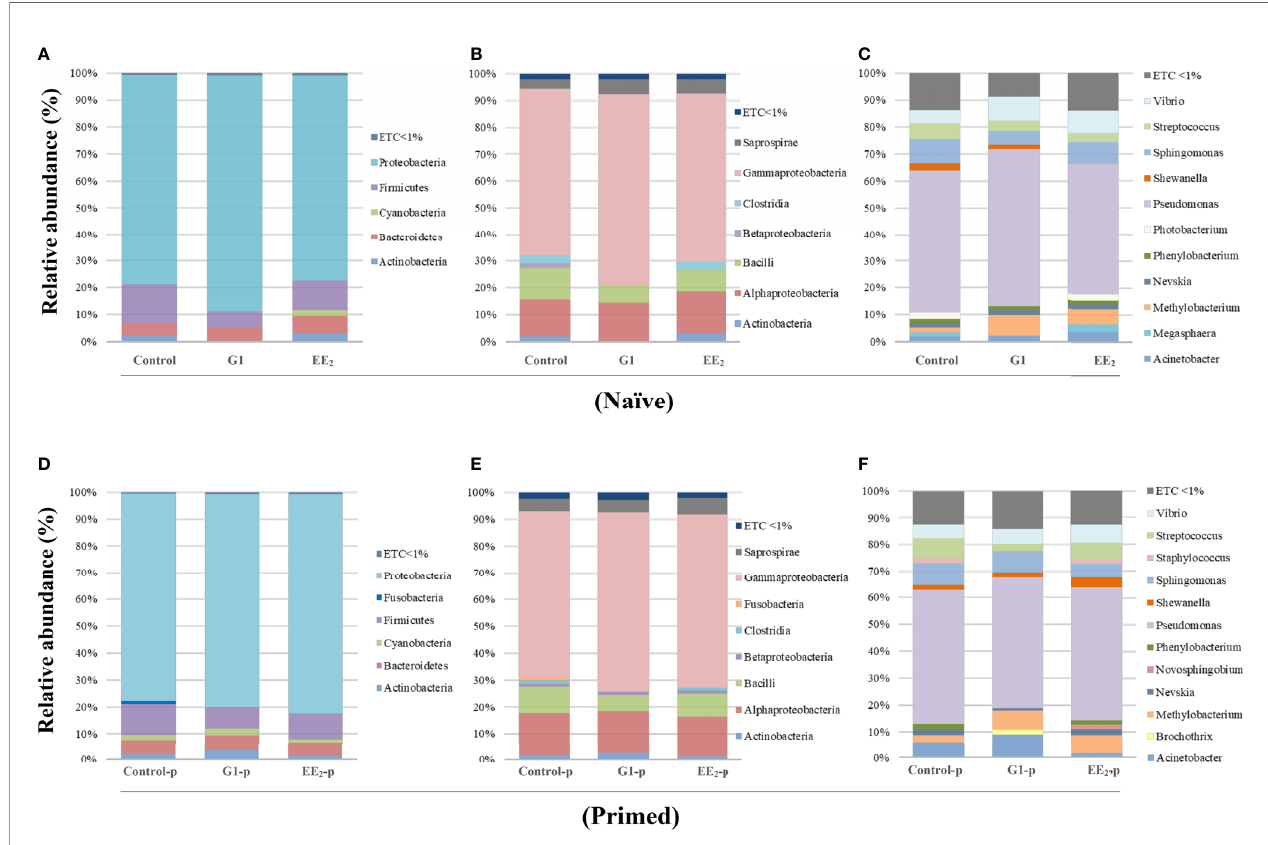
FIGURE 7 | Relative abundance of the intestinal bacteria communities of gilthead seabream, at different taxonomic levels is affected by the oral G1 and EE2 exposure and further potentiated by immune priming. Phyla (A, D) . Class (B, E) . Genera (C, F) . Left to right , representing the received dietary treatment received (Control, G1, or EE2). Up to down ; immune status (Naive or immune primed with KLH). ETC: average relative abundance < 1%, (n = 6).